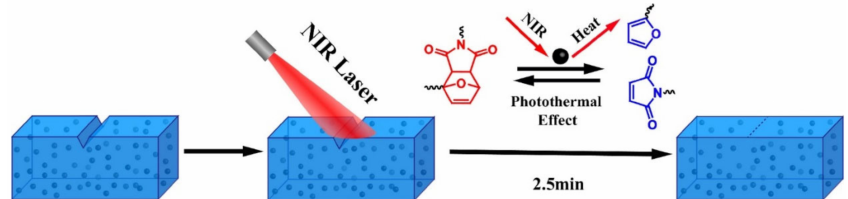
Figure 30. SHP self-healing process triggered by NIR laser. Reproduced from [176] with permission from John Wiley and